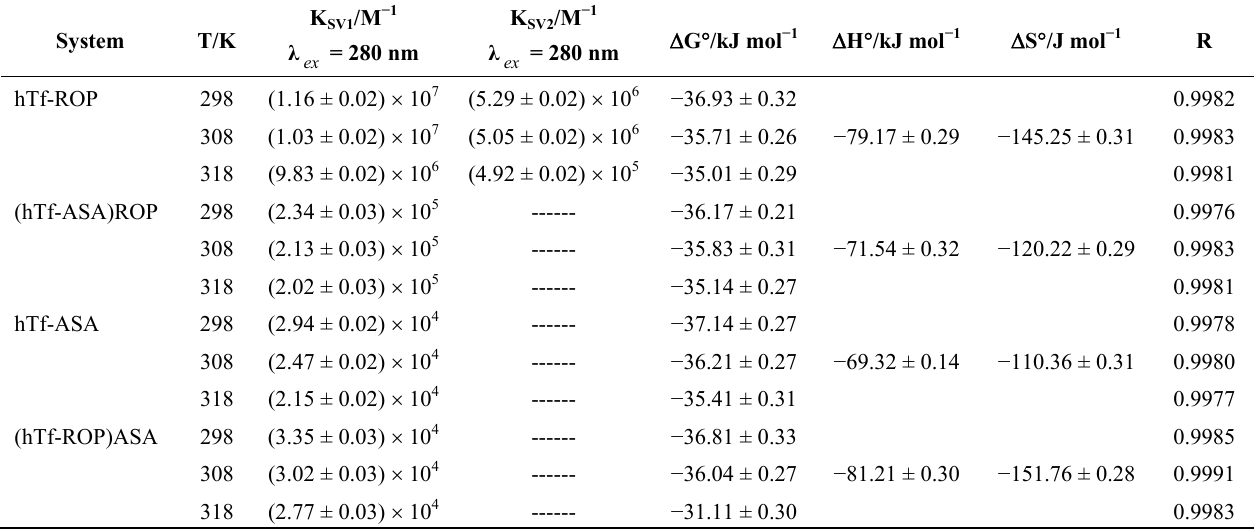
Table 1. Thermodynamic parameters and K binary and ternary systems at various temperatures (pH